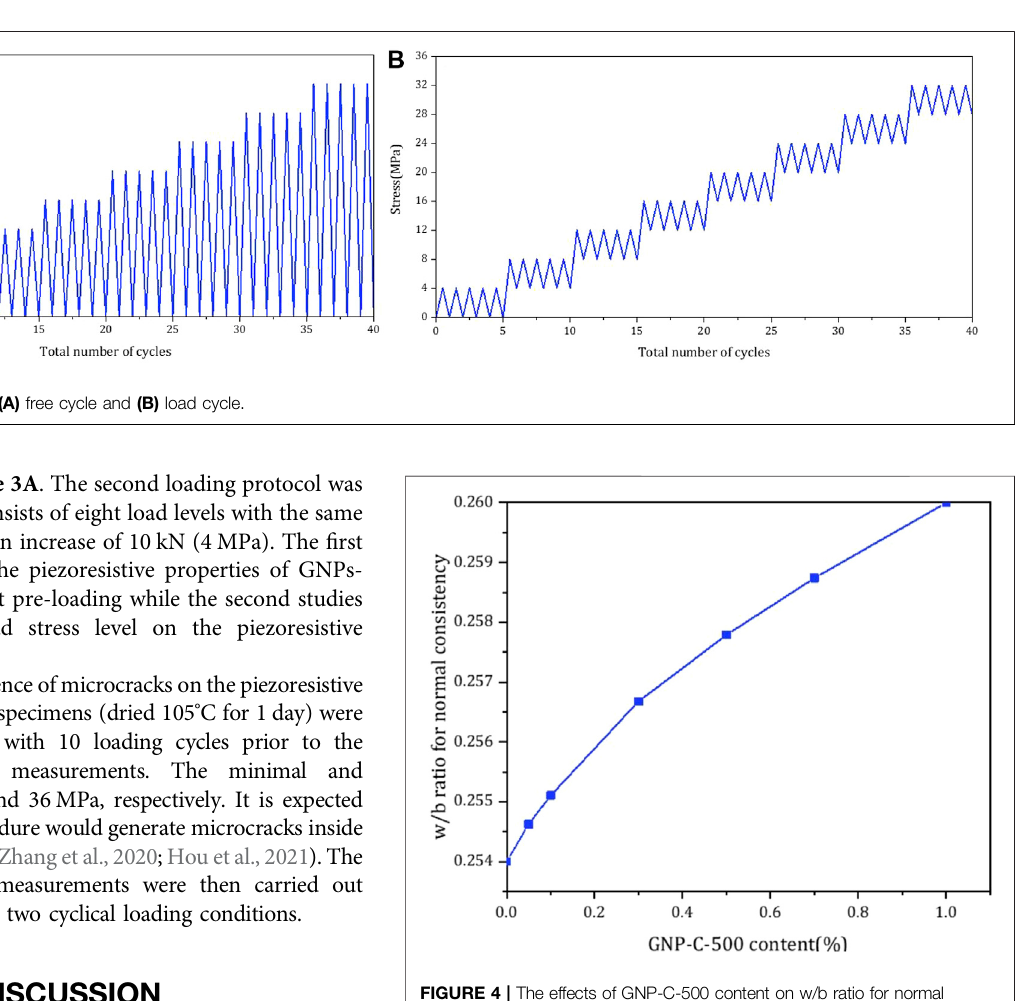
FIGURE 4 | The effects of GNP-C-500 content on w/b ratio for normal